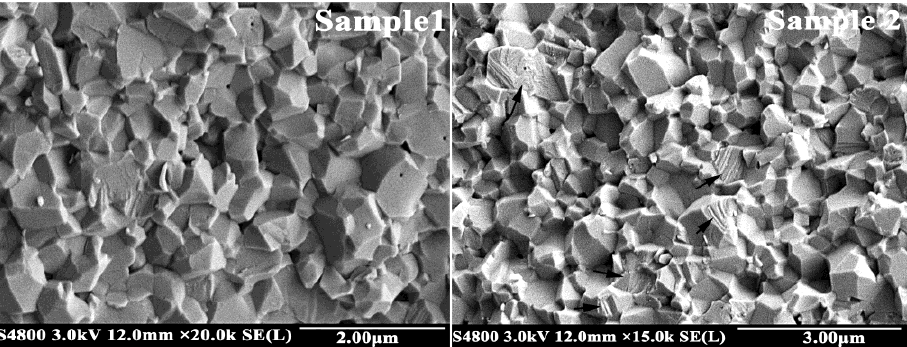
Figure 6. Fracture surfaces of Samples 1 and 2.